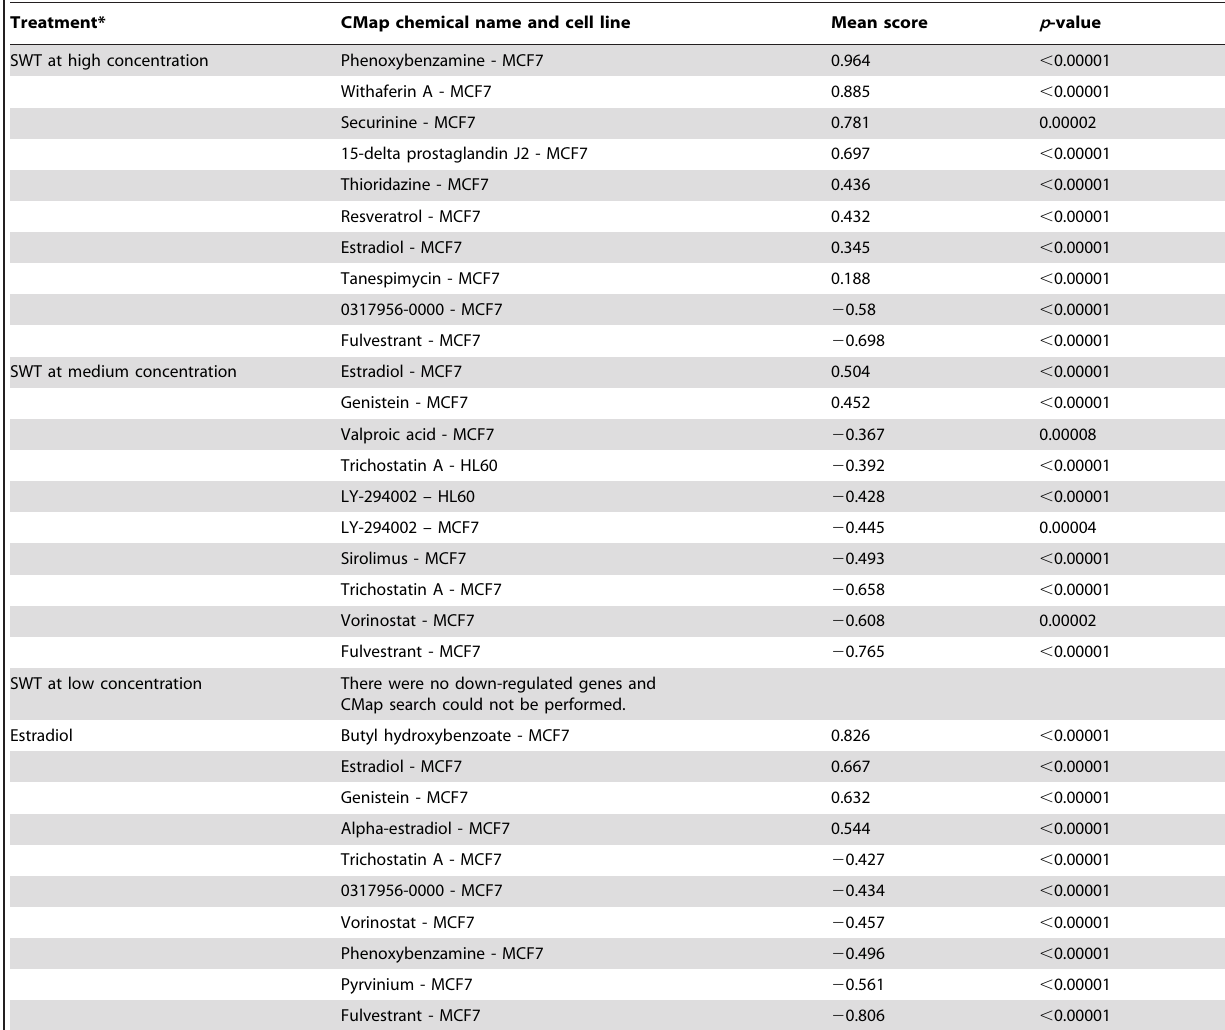
Table 5. Top CMAP hits correlated with SWT or estradiol treatment.